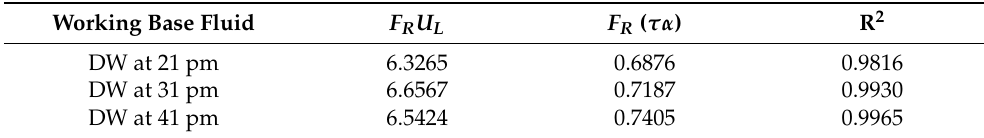
Figure 12. Variance of the collector’s thermal efficiency for the flow rate of DW. Table 4. Values for the removed energy parameter and the absorbed energy parameter, and the regression coefficient for the base working fluid at difference flow rates.